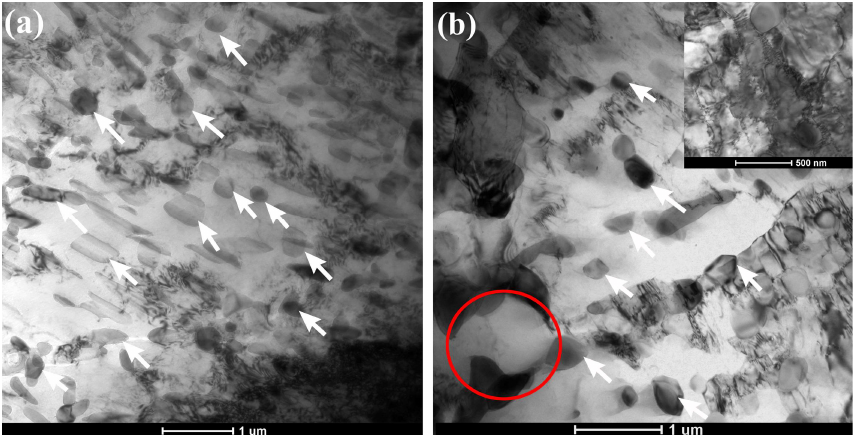
Figure 4. Transmission electron microscopy (TEM) micrographs of the AZ91alloy processed by ( a ) solution heat treatment and ECAP for eight passes, ( b ) SHT + ECAP 8p + rolling at 150 °C showing high density of dislocations around some particles.